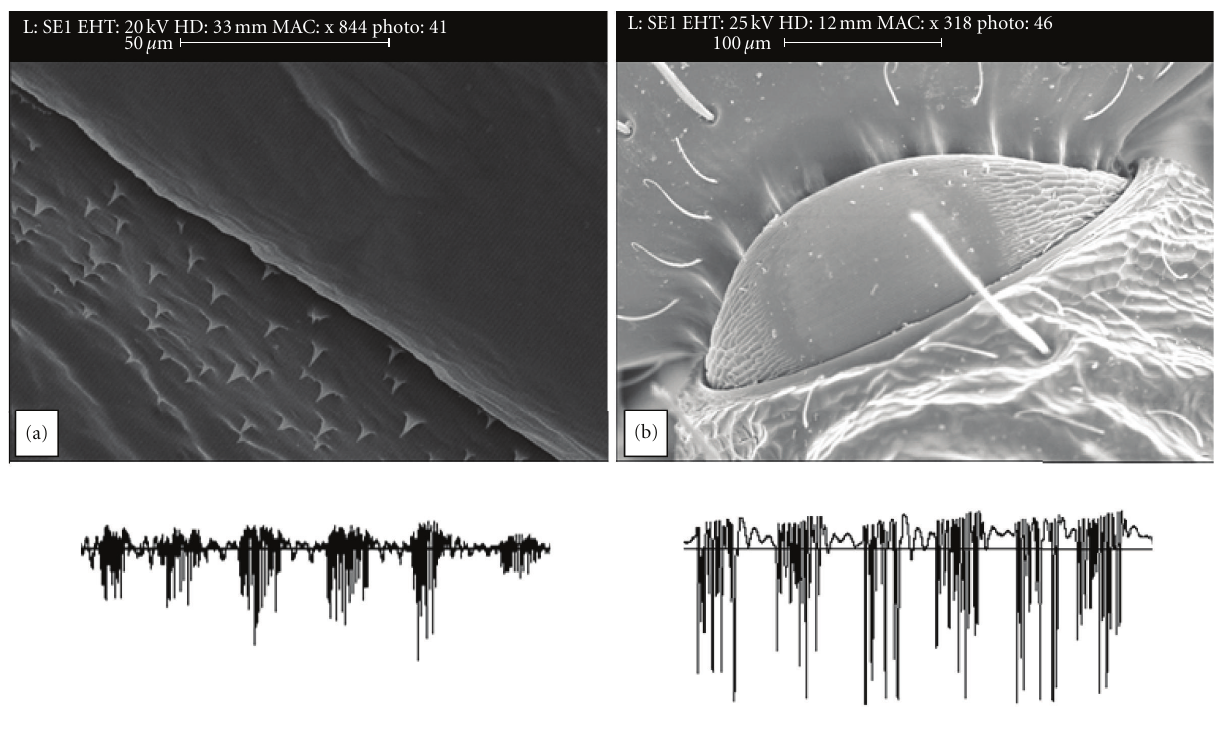
Figure 2: Morphology (upper part) and sounds (lower part) of the acoustical organs of (a) Maculinea rebeli pupa and (b) Myrmica schencki